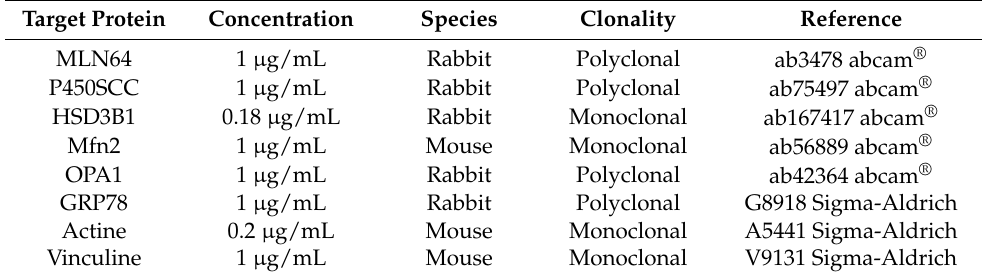
Table 1. References and concentrations of primary antibodies.